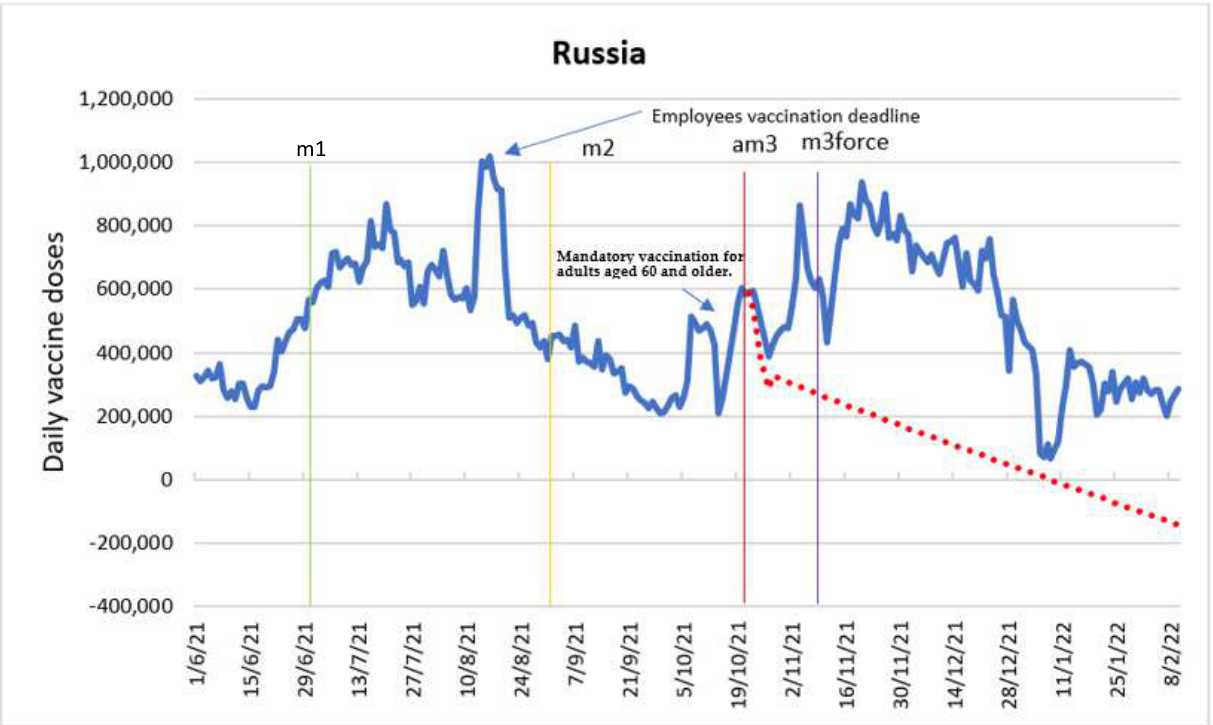
Figure 6 . Daily new vaccinations in Russia before and after the policy changes and predicted values Figure 6. Daily new vaccinations in Russia before and after the policy changes and predicted values Figure 1. Daily new vaccinations in Austria before and after the policy changes and predicted values Figure 1. Daily new vaccinations in Austria before and after the policy changes and predicted values Figure 1. Daily new vaccinations in Austria before and after the policy changes and predicted values Figure 1. Daily new vaccinations in Austria before and after the policy changes and predicted values Figure 1. Daily new vaccinations in Austria before and after the policy changes and predicted values in absence intervention based on ARIMA models. in absence intervention based on ARIMA models. in absence of intervention based on ARIMA model. in absence of intervention based on ARIMA model. in absence of intervention based on ARIMA in absence of intervention based on ARIMA model. in absence of intervention based on ARIMA model.